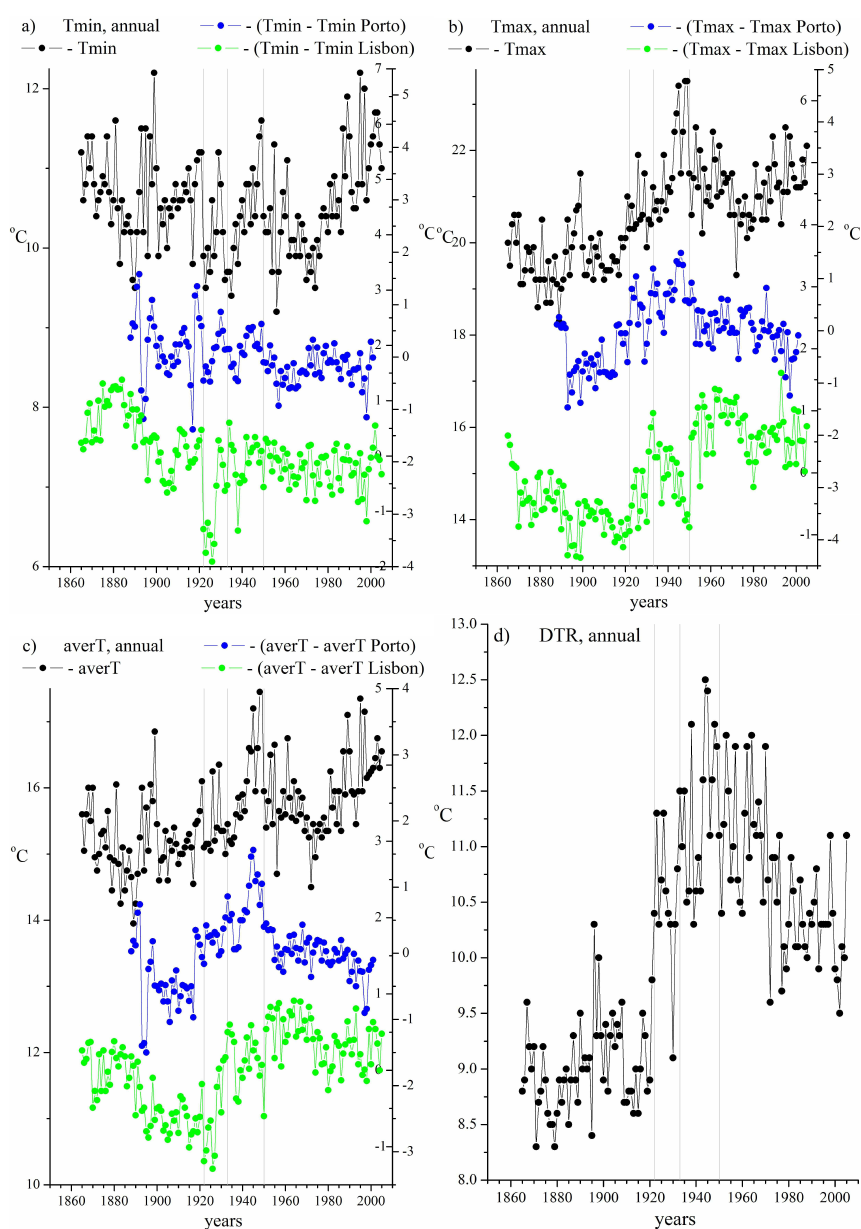
Figure 19. Coimbra: annual variations of T min (a) , T max (b) , T aver (c) and DTR (d) ; Coimbra temperature series (black) and di ff erences between Coimbra and Porto (blue) and Lisbon (green) temperature series. Grey vertical bands show dates of known instruments relocation (see Table